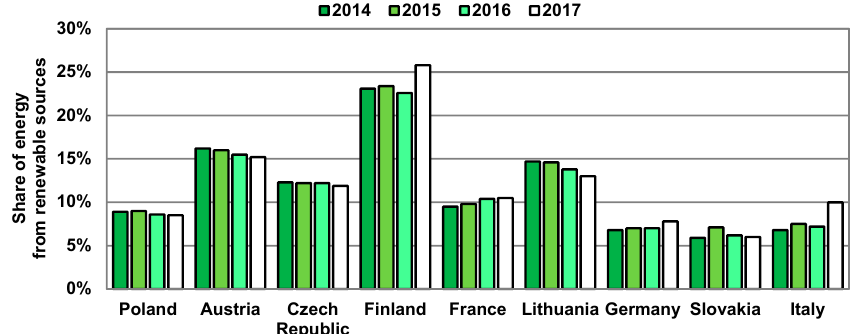
Figure 7. Share of energy from renewable sources in final consumption [13].